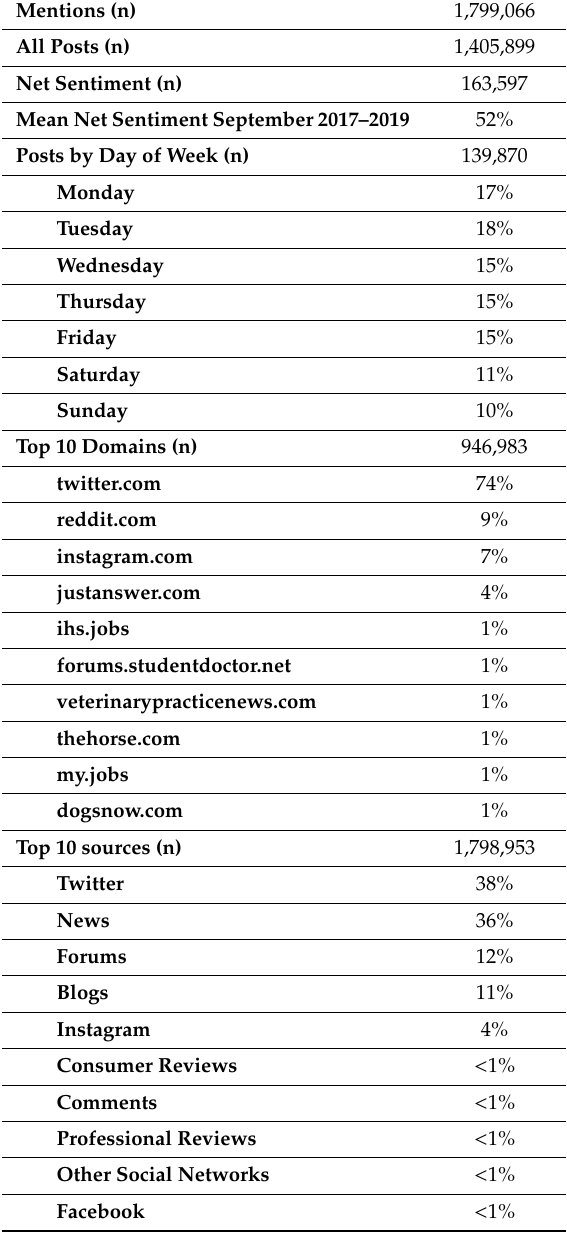
Table 2. Mentions, average sentiment, day of week and top 10 domains and